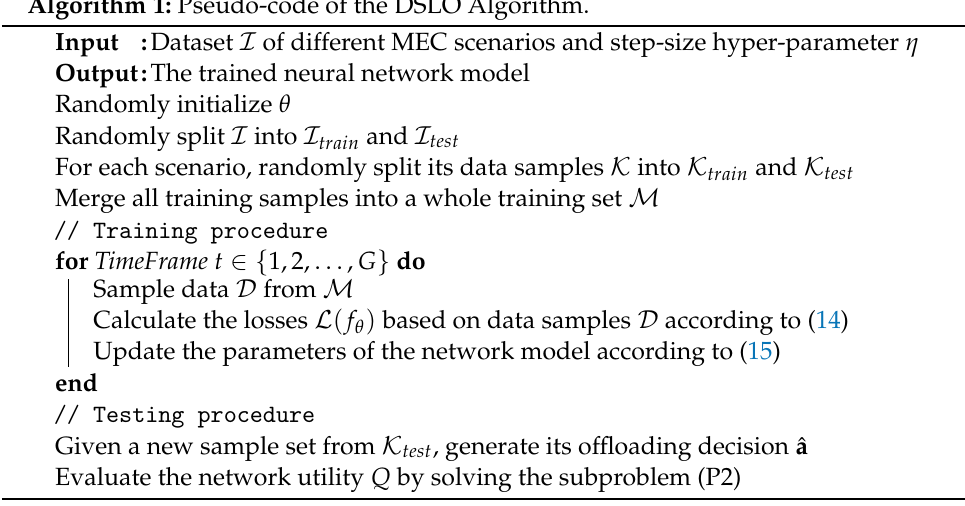
Algorithm 1: Pseudo-code of the DSLO